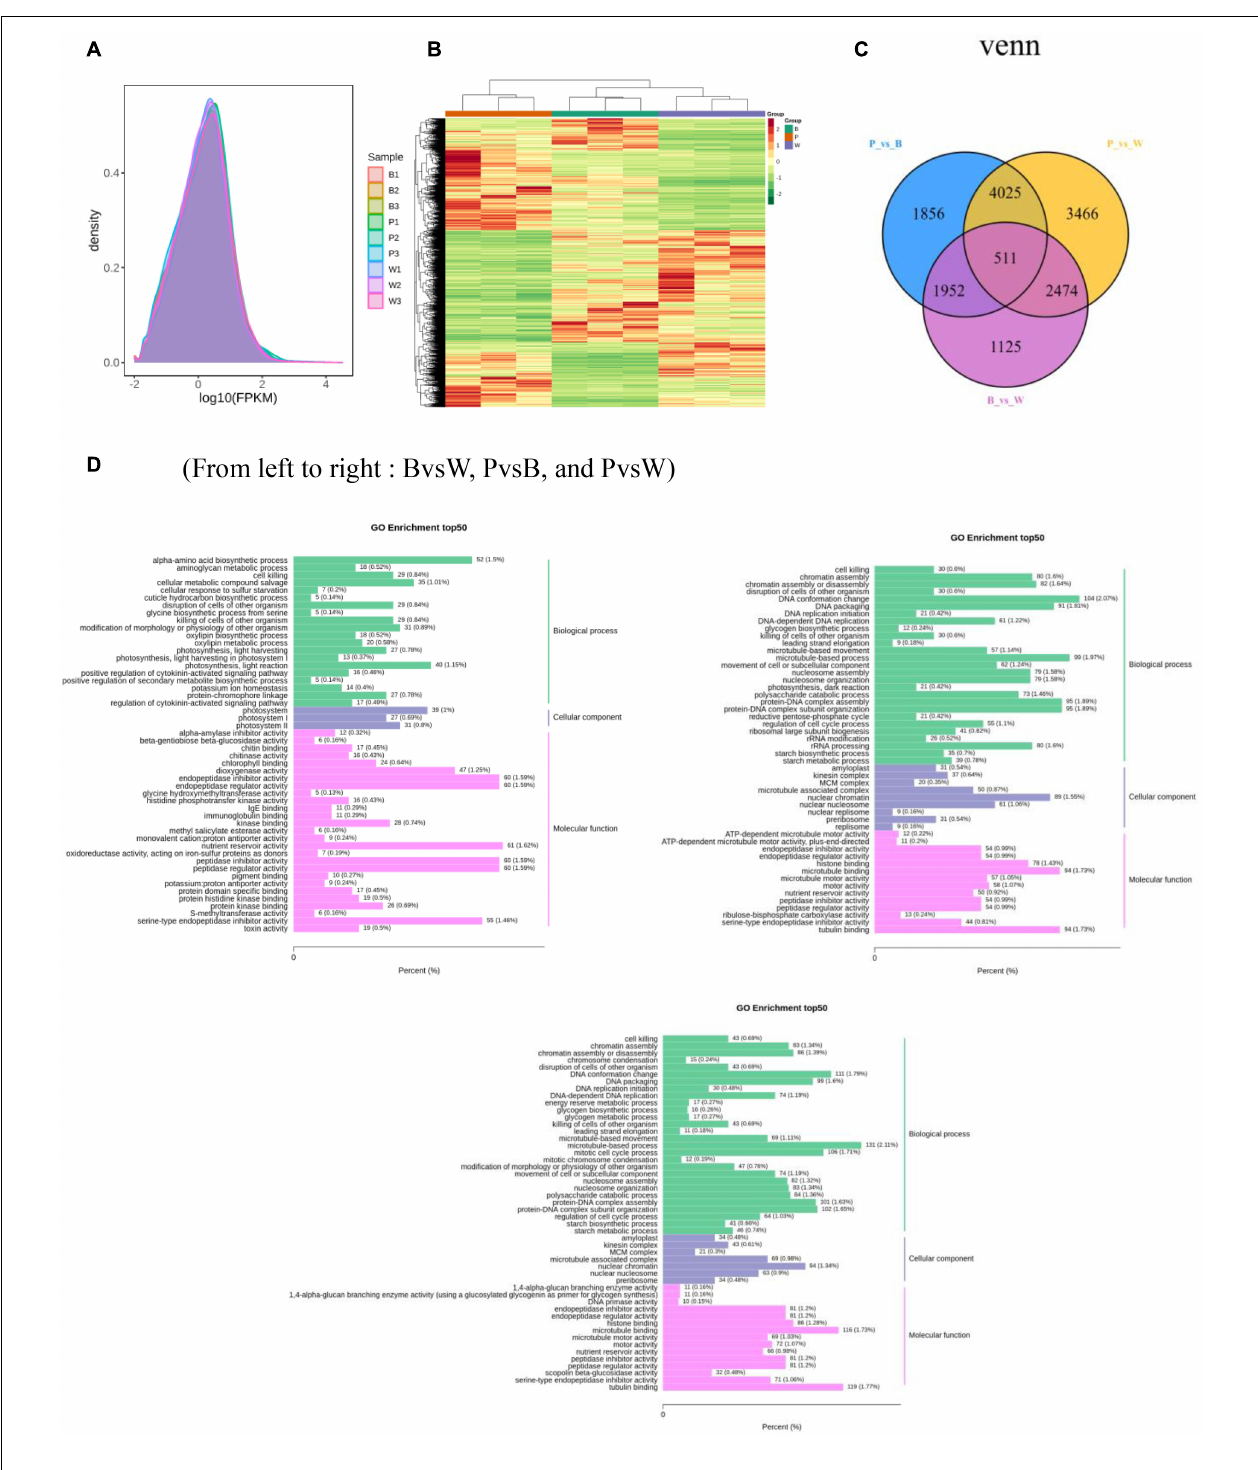
FIGURE 5 | (A) Gene expression density distribution map. (B) Differential gene clustering heat map. (C) Differential gene Venn diagram. (D) Differential gene GO enrichment bar chart. (A) The curves of different colors in the figure represent different samples, the horizontal coordinates of the points on the curves indicate the logarithmic values of FPKM of the corresponding samples, and the vertical coordinates of the points indicate the probability density. (B) Horizontal coordinates indicate sample names and hierarchical clustering results, and vertical coordinates indicate differential genes and hierarchical clustering results. Red indicates high expression, green indicates low